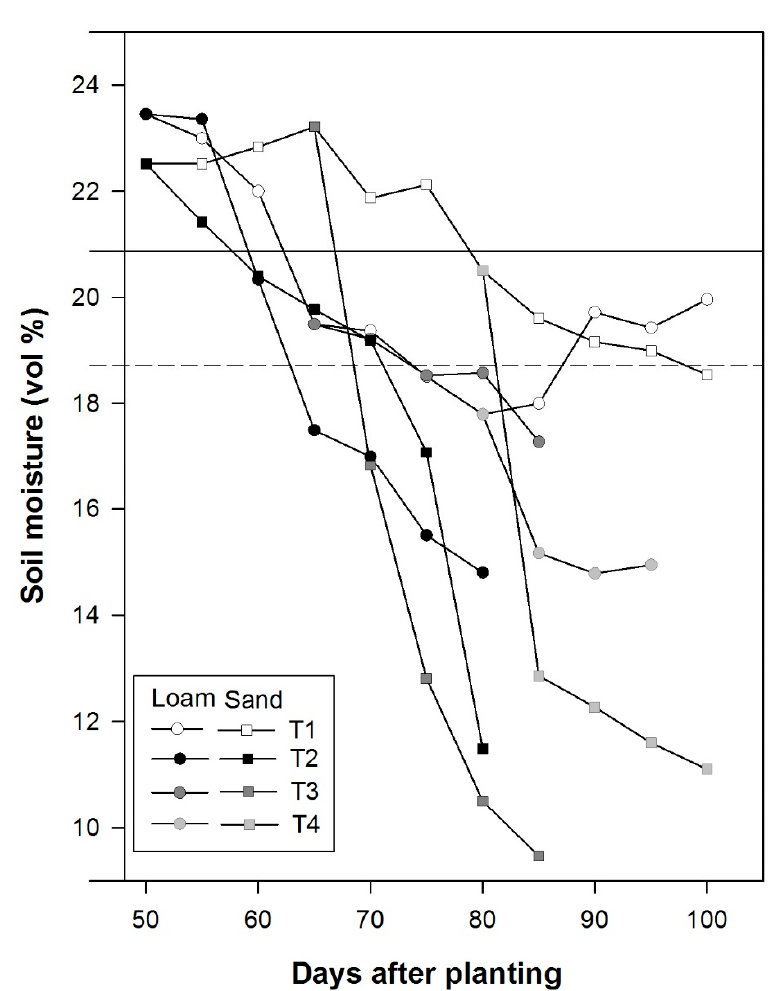
Figure 1. Evolution of mean soil moisture by treatment in volume percentage for the four irrigation treatments (T1–T4) in loamy sand (Loam) and sandy soil (Sand). Measurements were taken in five-day intervals per genotype (G1–G5, Appendix B), treatment, and replication. Each data point represents a mean of 15 measurements of the average soil moisture from 10–40 cm depth. Error bars have been omitted for readability. Solid horizontal line: Irrigation target loam; broken horizontal line: Irrigation target sand.